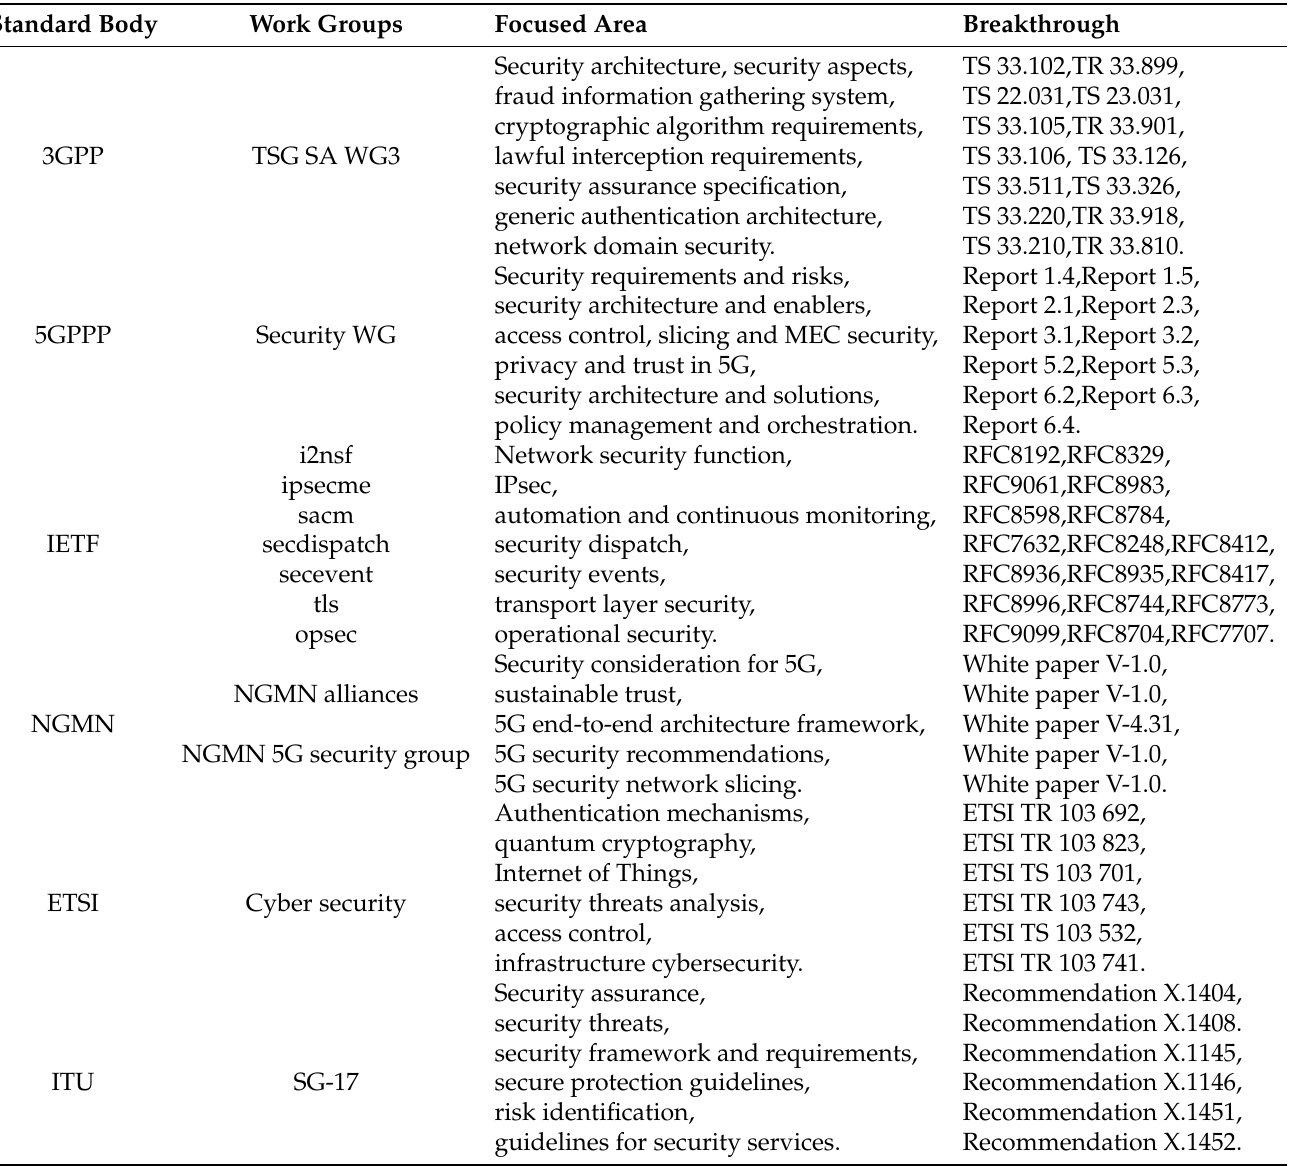
Table 9. Standard bodies working in the security and privacy